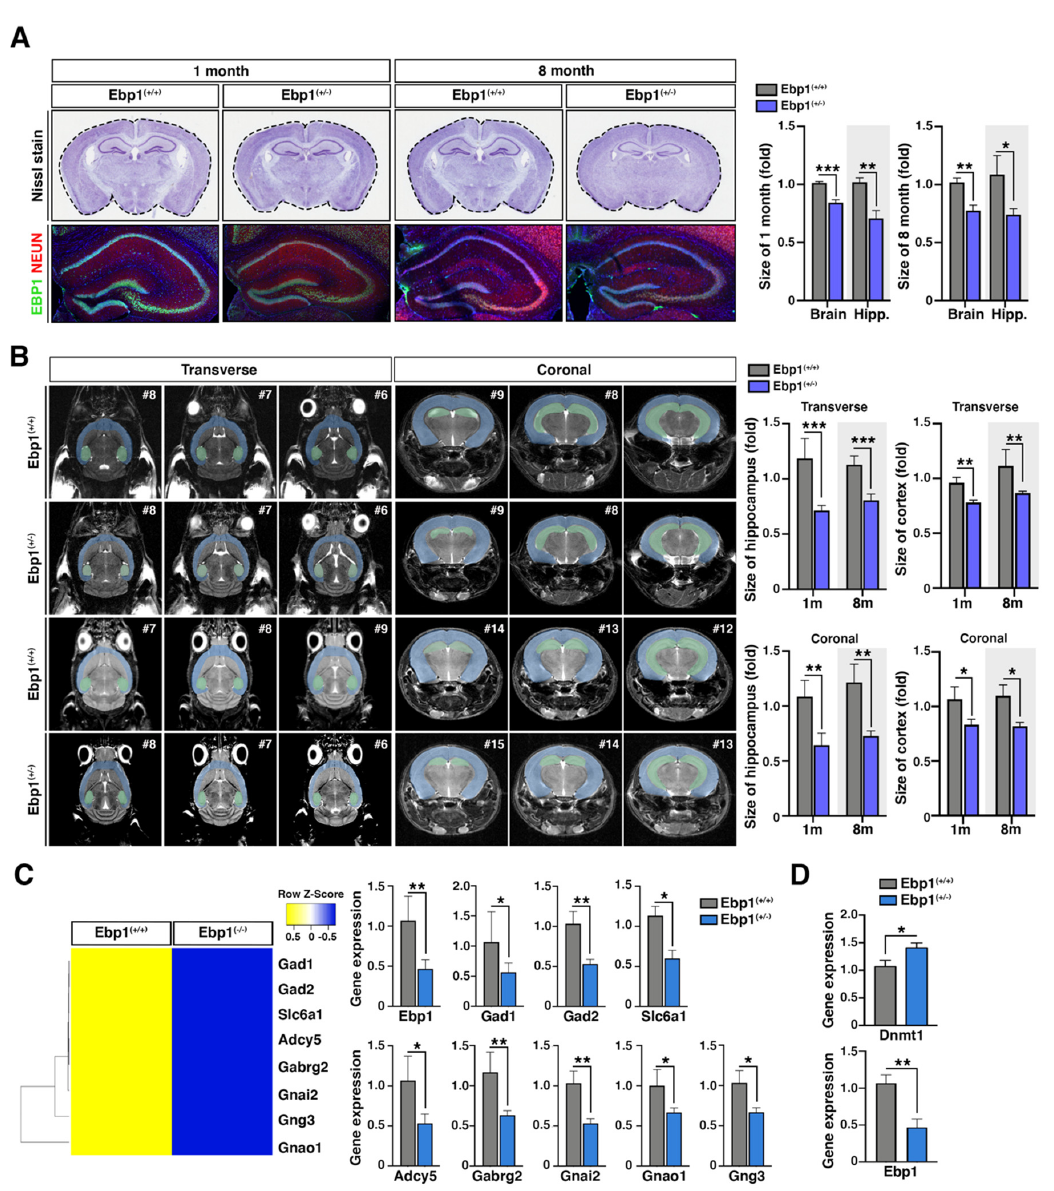
Figure 1. Deficits in hippocampus development in Ebp1 (+/ − ) mice. ( A ) Ebp1 (+/+) and Ebp1 (+/ − ) 1 month and 95 8 month old mouse brains were isolated and subjected to Nissl staining (to compare the brain sizes 96 (upper)) or was stained with anti- ErbB3-binding protein 1 (EBP1) (red, marker for EBP1) and anti- 97 NEUN (green, marker for neuronal cell) antibodies (to compare sizes of hippocampus (bottom)). The 98 whole brain size of Ebp1 (+/ − ) mouse was smaller than that of Ebp1 (+/+) for about 15%. Especially, the 99 hippocampus size was much smaller than that of Ebp1 (+/+) for about 30% 8 months after birth. Bar 100 graphs display quantified data (right). * p < 0.05, ** p < 0.01, *** p < 0.001. scale bar: 500 μ m. ( B ) 101 Representative images of the whole brain structure of Ebp1 (+/+) and Ebp1 (+/-) mouse are shown; coronal 102 (right) and transverse (left) T2-weighted images; MRI images of brain from 1 month (upper) or 8 103 month mice (bottom). Representative galleries of T2-weighted MRI images are shown. MRI was used 104 to determine the size of hippocampus. The hippocampus (light green) and cortex (light blue) are 105 highlighted. Bar graphs display quantified data (right). * p < 0.05, ** p < 0.01, *** p < 0.001. ( C ) The 106 hierarchical clustering of differentially expressed RNA of GABAergic neuron gene set was derived 107 using microarray of E12.5 Ebp1 deficient mouse brain samples. In the cluster heat map, red indicates 108 high relative gene expression and green indicates low relative gene expression. To confirm down 109